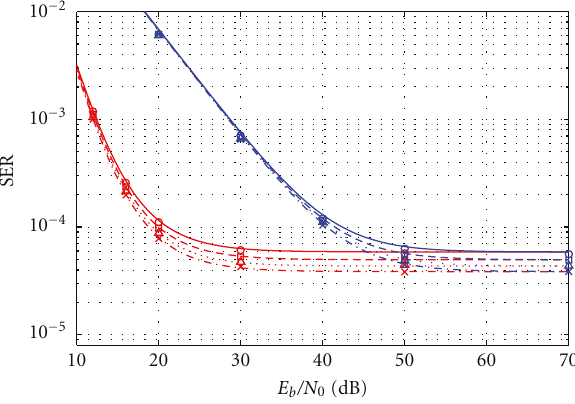
Figure 3: Symbol Error Rate (SER) comparison between the analytical approach (line) and the simulation results (marker) over AWGN channel (red) and frequency-nonselective slowly fading channel (blue), where the data is QPSK modulated, and 1024- point FFT pairs are considered. The OFDM symbols are clipped at λ = 0dB. In the figure, the lines represent our analytical approach, such as solid line ( n = 1), dash line ( n = 2), dot line ( n = 4), and dash-dot line ( n = 8). The markers represent the simulation results, such as ◦ ( n = 1), (cid:4) ( n = 2), (cid:5) ( n = 4), × ( n = 8).